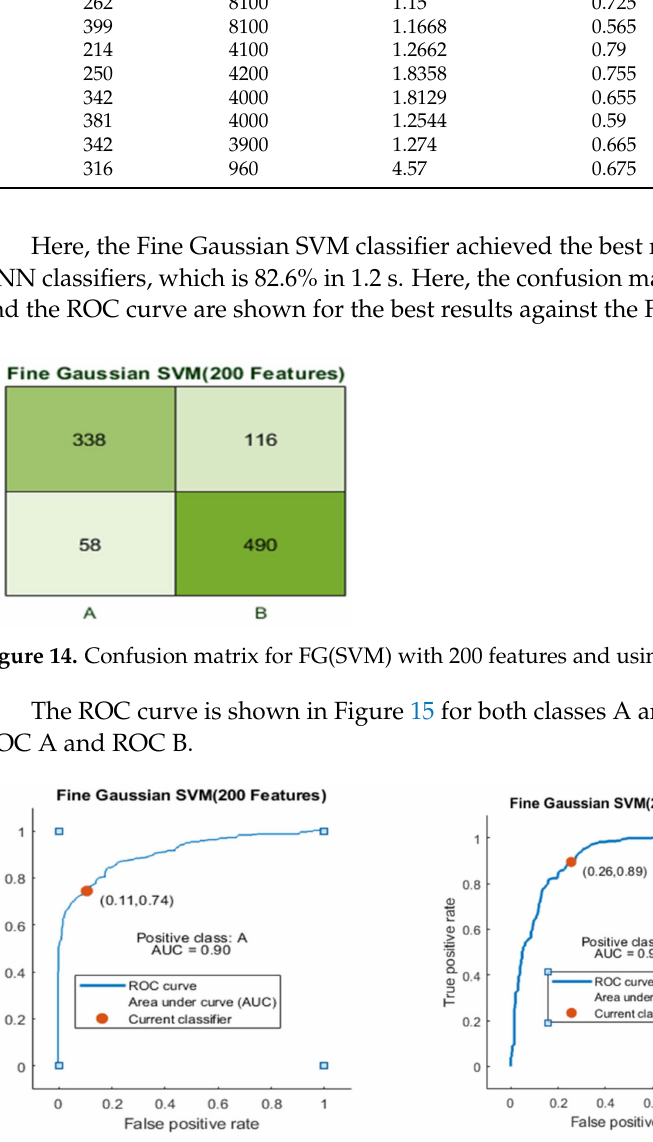
Figure 15. ROC curve for two classes A and B with 200 features and using 10-fold results. Experiment_3: Using 5-Fold and 10-Fold Validation on 500